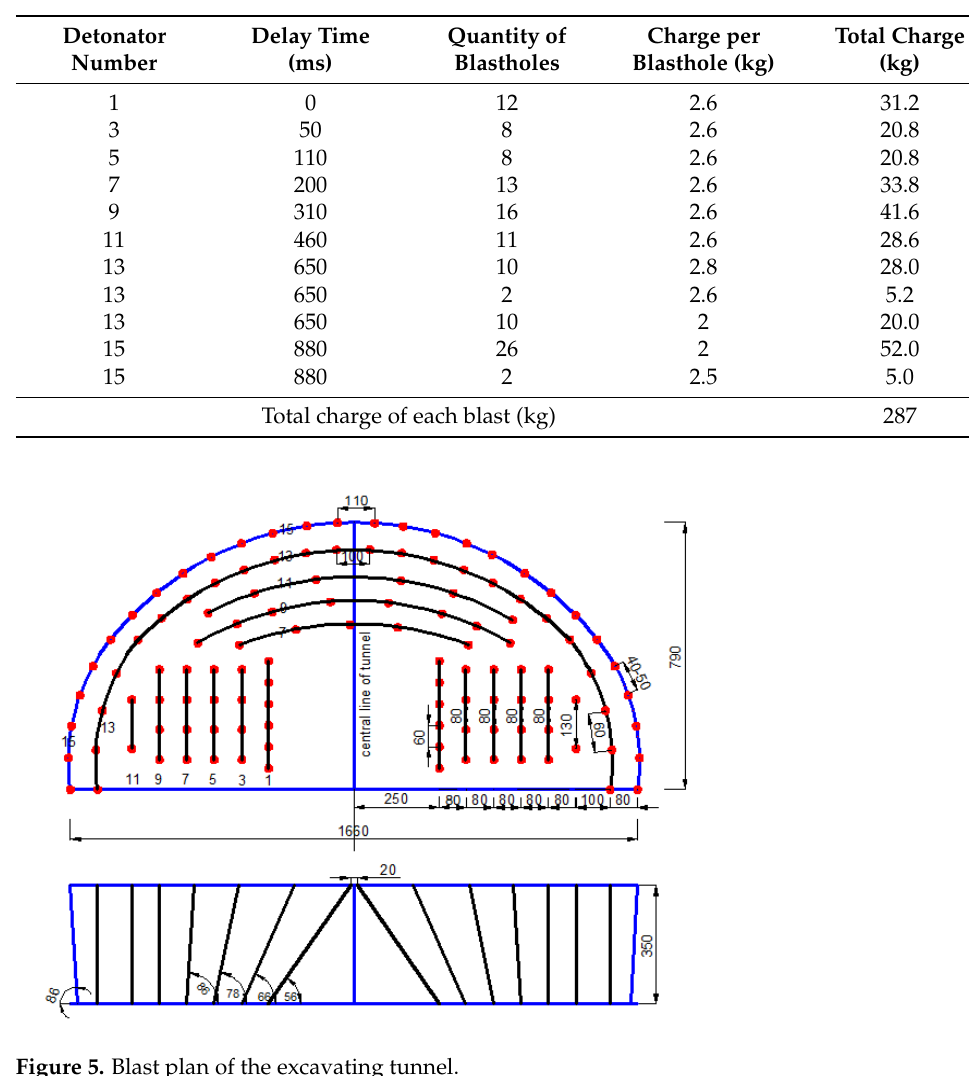
Figure 4. Blasting bench of the excavating tunnel. ( a ) The bench method; ( b ) The full-face method. Table 1. Parameters of each blast.